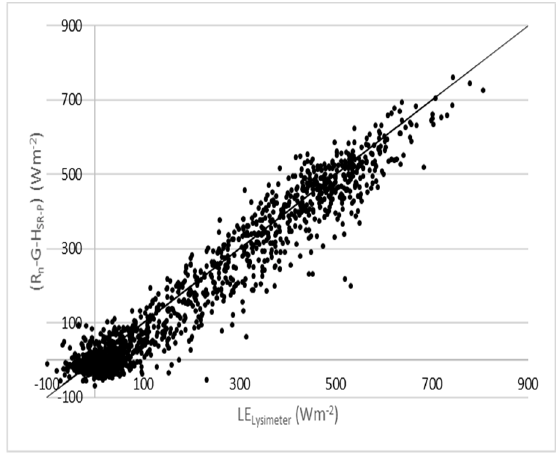
Figure 3. (R n − G − H SR-P ) against the reference for all the data. The 1:1 ratio line (thin solid) is shown.